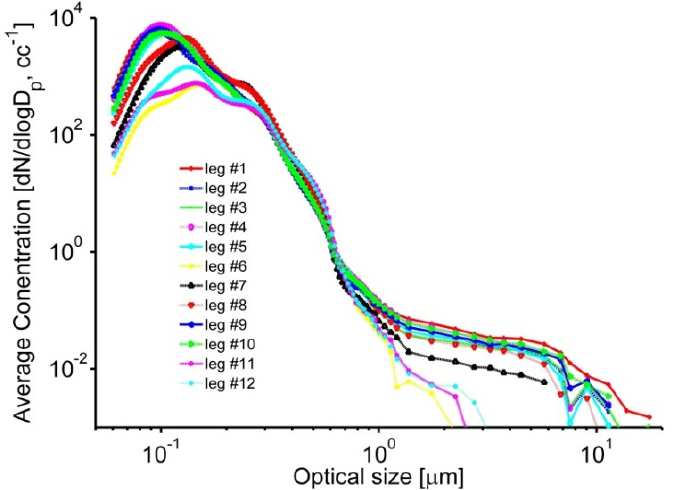
Figure 2. Example of combined size distributions generated for each FL during a given day (21 July 2012). Here and in the following plots, aerosol characteristics represent FL-averaged values. Elevation and time of each FL are shown in Figure 3.